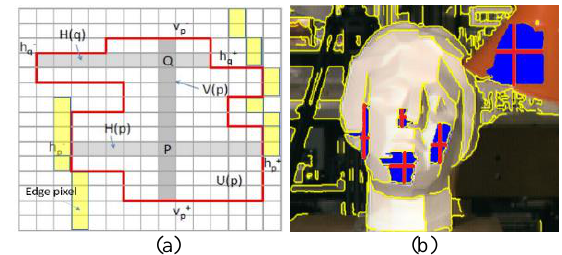
Figure 4. Demonstrations of the shape-adaptive cross-based matching cost aggregation with the edge constraint.